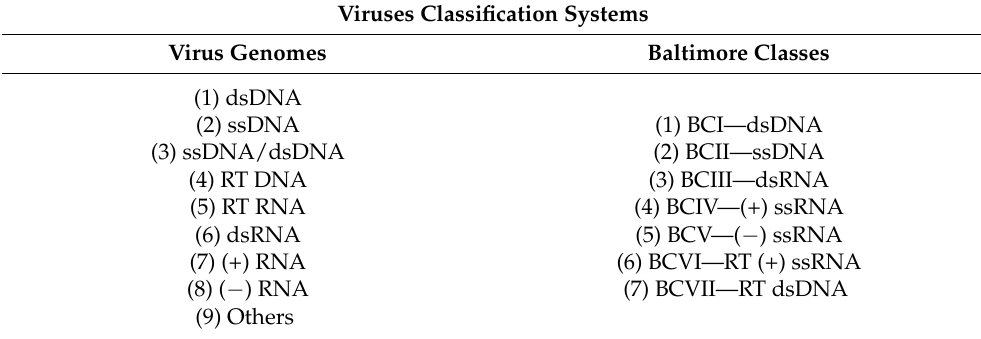
Table 1. Two classification systems for viruses based on the virus genome and Baltimore